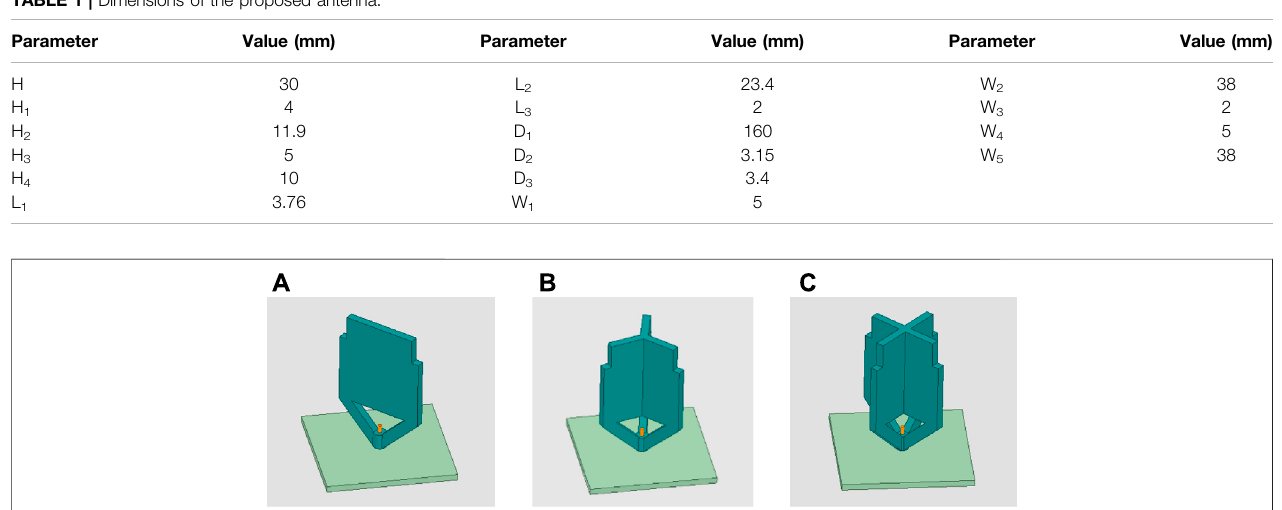
TABLE 1 | Dimensions of the proposed antenna.